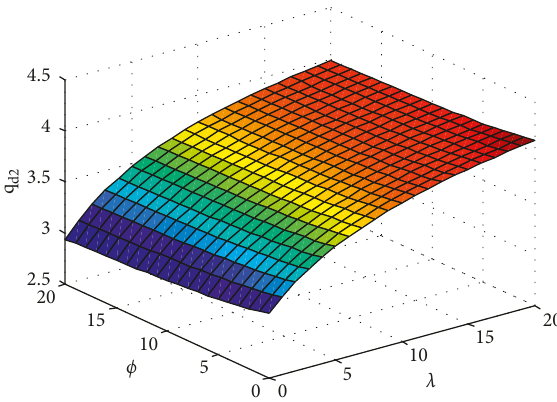
Figure 9: Impacts of dual-fairness concern on the ordering quantity of retailer